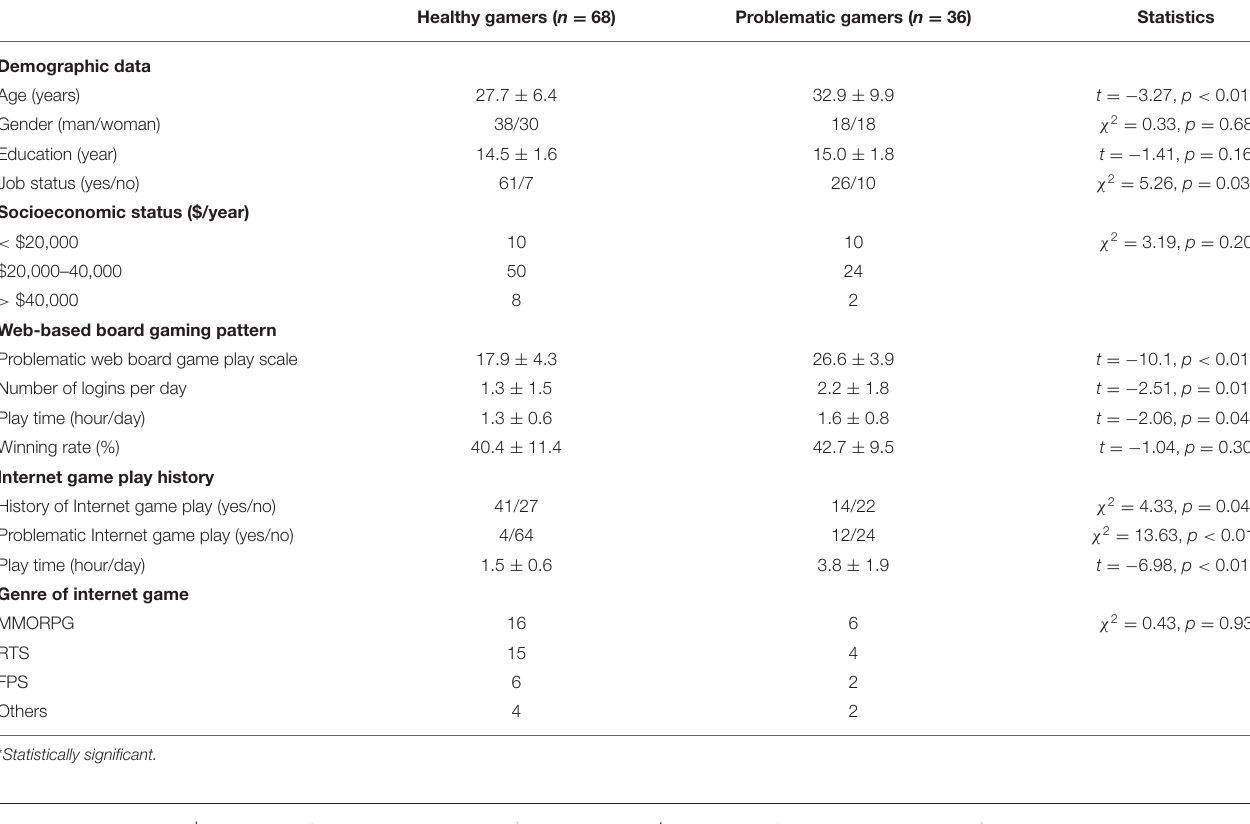
TABLE 1 | Demographic and gaming characteristics of web-based board gamers.